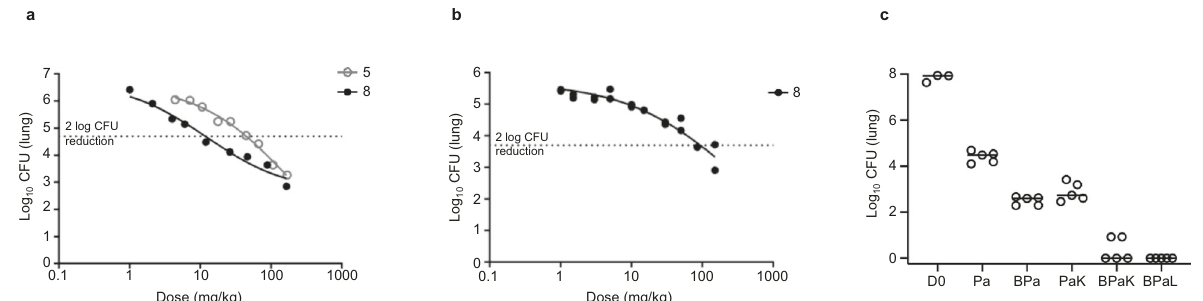
Fig. 3 | In vivo ef fi cacy of LysRS inhibitors in murine models of M. tuberculosis infection. a Compounds 5 and 8 were tested in an acute model of infection in C57BL/6mice.Dosingstarted1dayafterinfectionandlastedfor8days;eachgroup consisted of one mouse/dose. The effect on the number of colony-forming units (CFU) in mouse lungs is shown. b Compound 8 was tested in a chronic model of infection in C57BL/6 mice. Dosing started 6 weeks after infection and lasted for